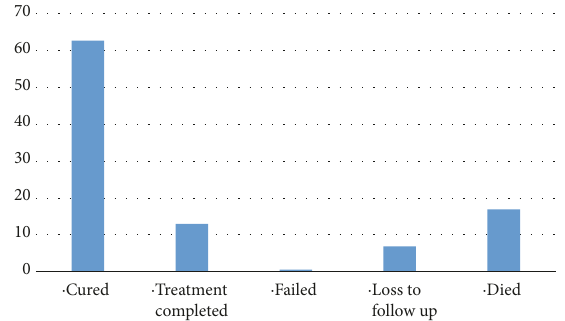
Figure 2: Percentages of patients’ treatment outcomes